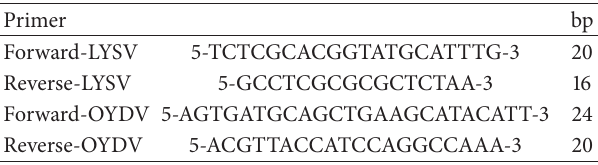
Table 1: Primers used in the study [11].